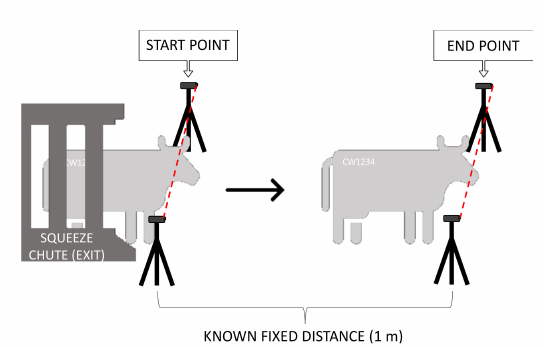
Figure 3. Flight time measurement. The sensors were placed on tripods, one sensor in each side (left and right) of the exit the way that they are parallel and facing each other. One pair of sensors (start point) were placed right after the headgate of squeeze chute (exit). The second pair (end point) were placed 1m in front of the first pair of